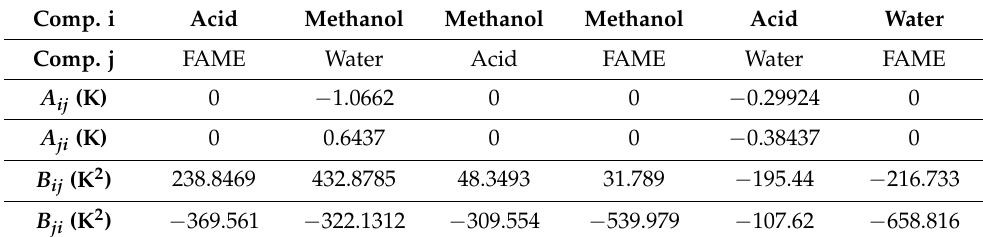
Table 1. Binary parameters of UNIQUAC activity model.